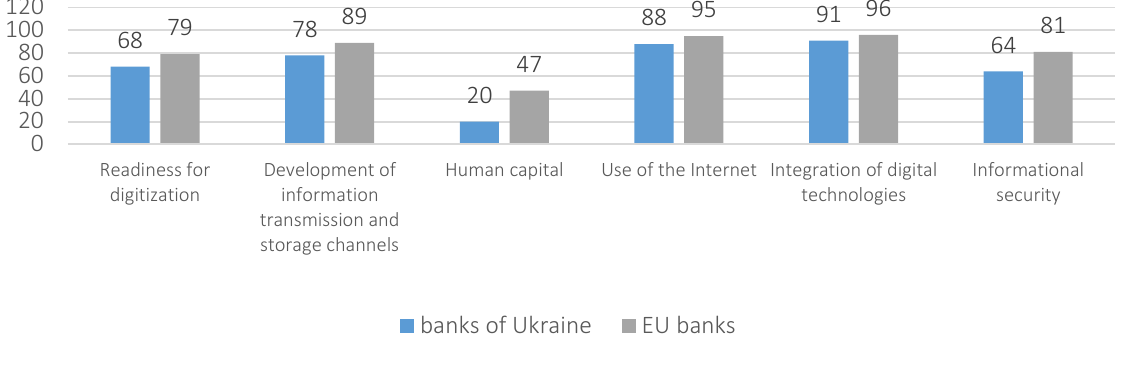
Figure 6. Index of readiness for digitalization of banks in Ukraine and the EU in 2020, %